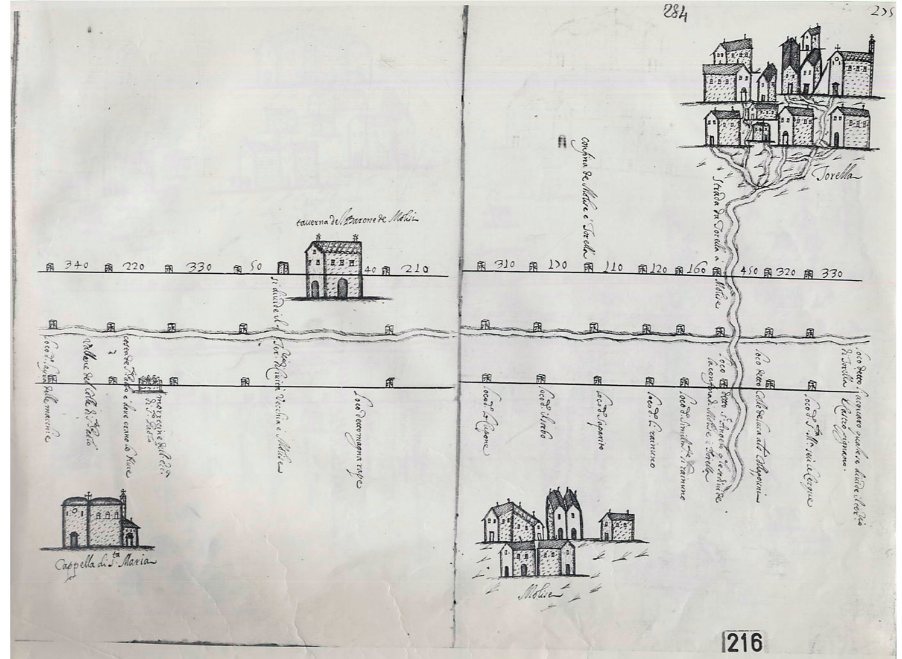
Figure A1. Details of Capecelatro’s Atlas, Sheet 284. In the map, in addition to the tavern, it is possible to recognize the milestones with related distances in Neapolitan feet. Authorization to publish